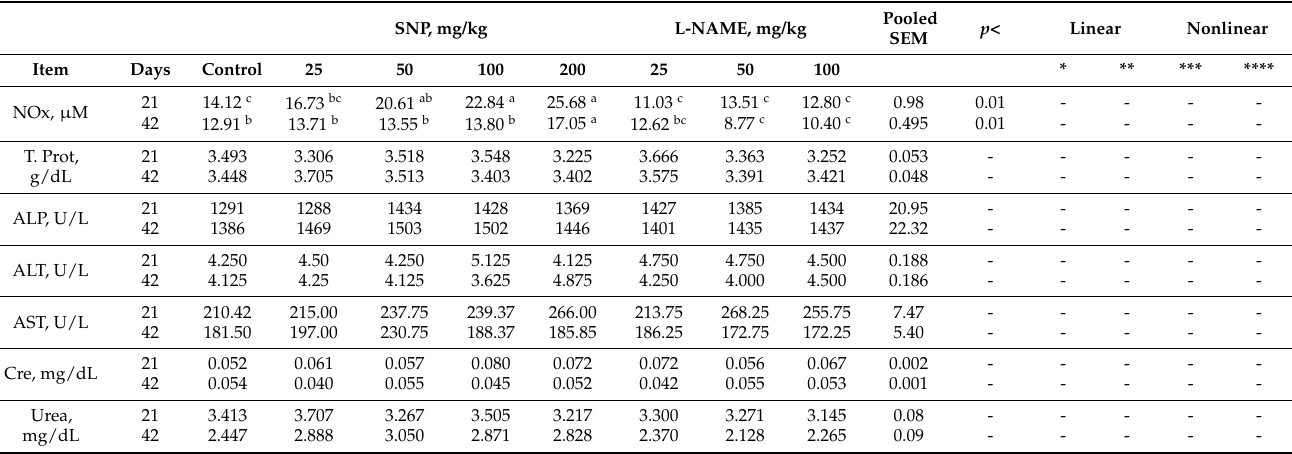
Table 5. Effect of dietary sodium nitroprusside (SNP) and N G -nitro-L-arginine methyl ester (L-NAME) supplementation on some serum biochemistry